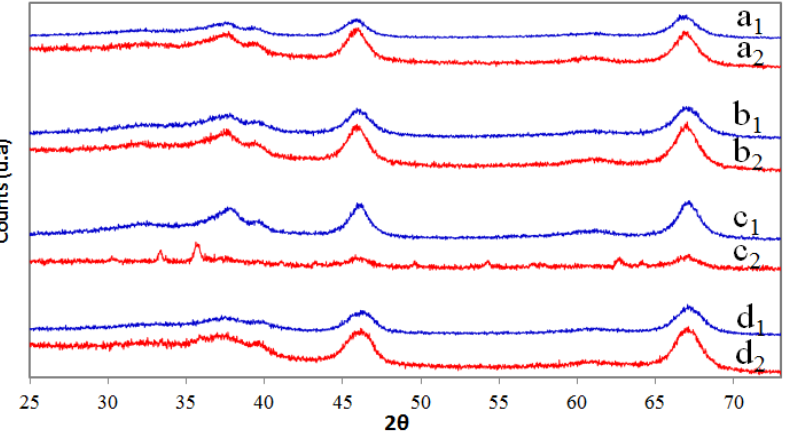
, b , c and d ) 1 1 1 1